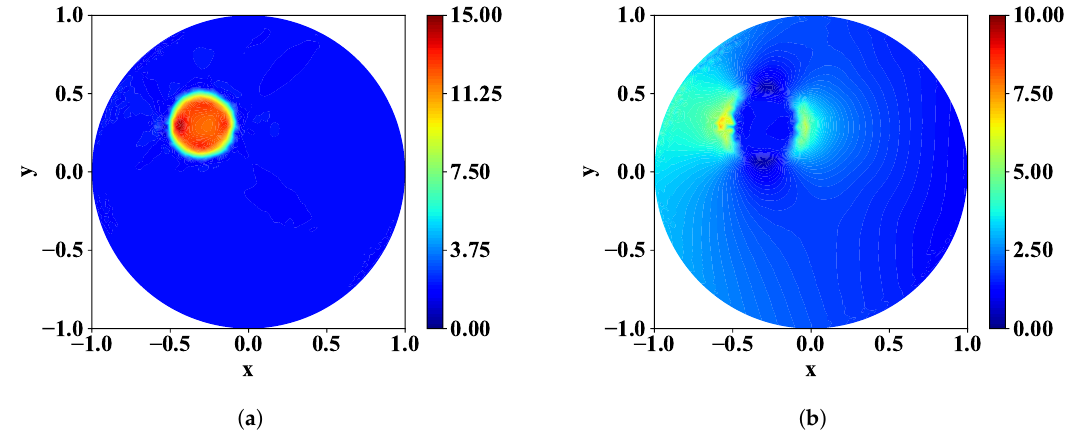
Figure 6. When SNR = ∞ , σ = 12.0S/m and the step is 7: ( a ) the reconstructed image and ( b ) the power